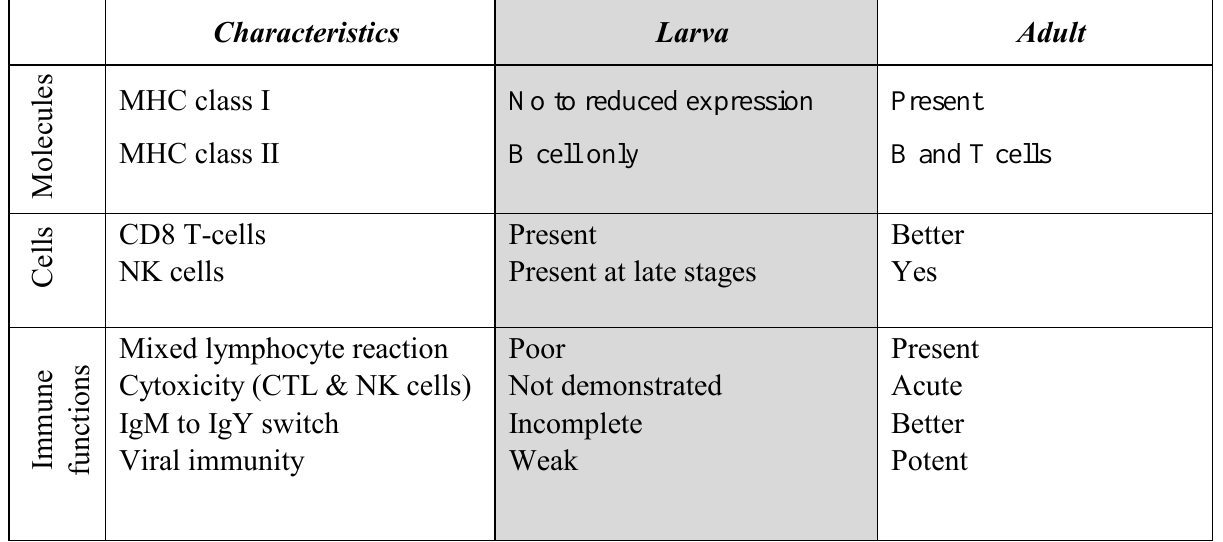
Table 1. Overview of the larval and adult immune system of X.